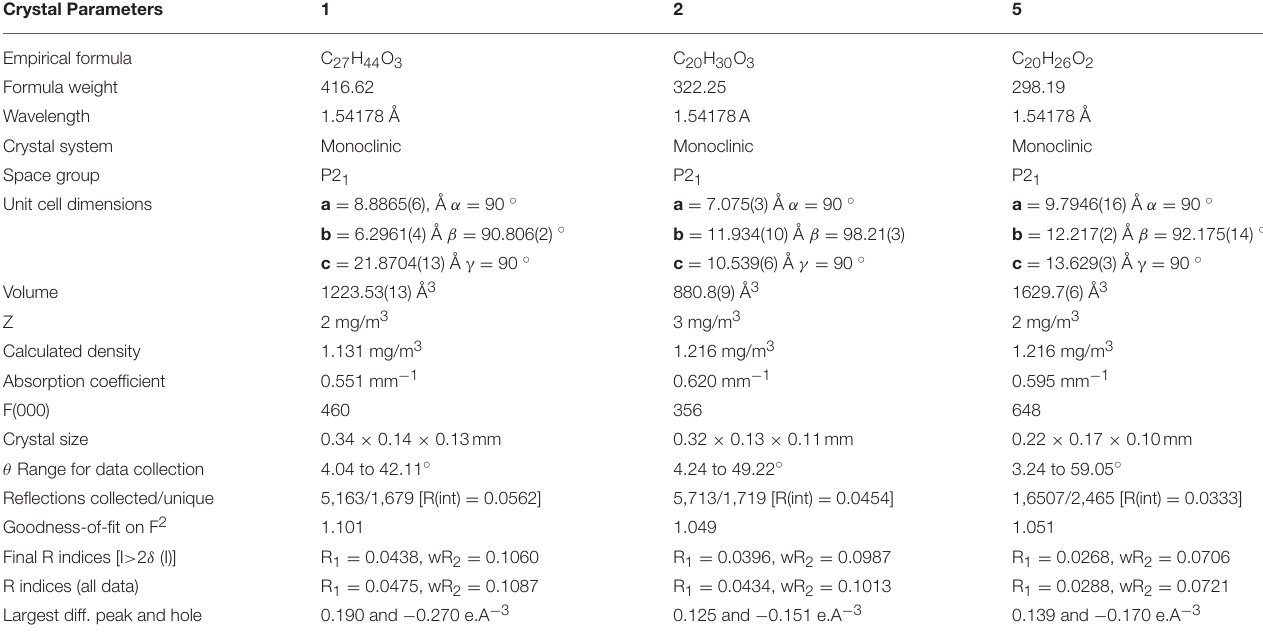
TABLE 4 | Single-crystal X-ray diffraction analysis of compounds 1, 2, and 5 . Crystal